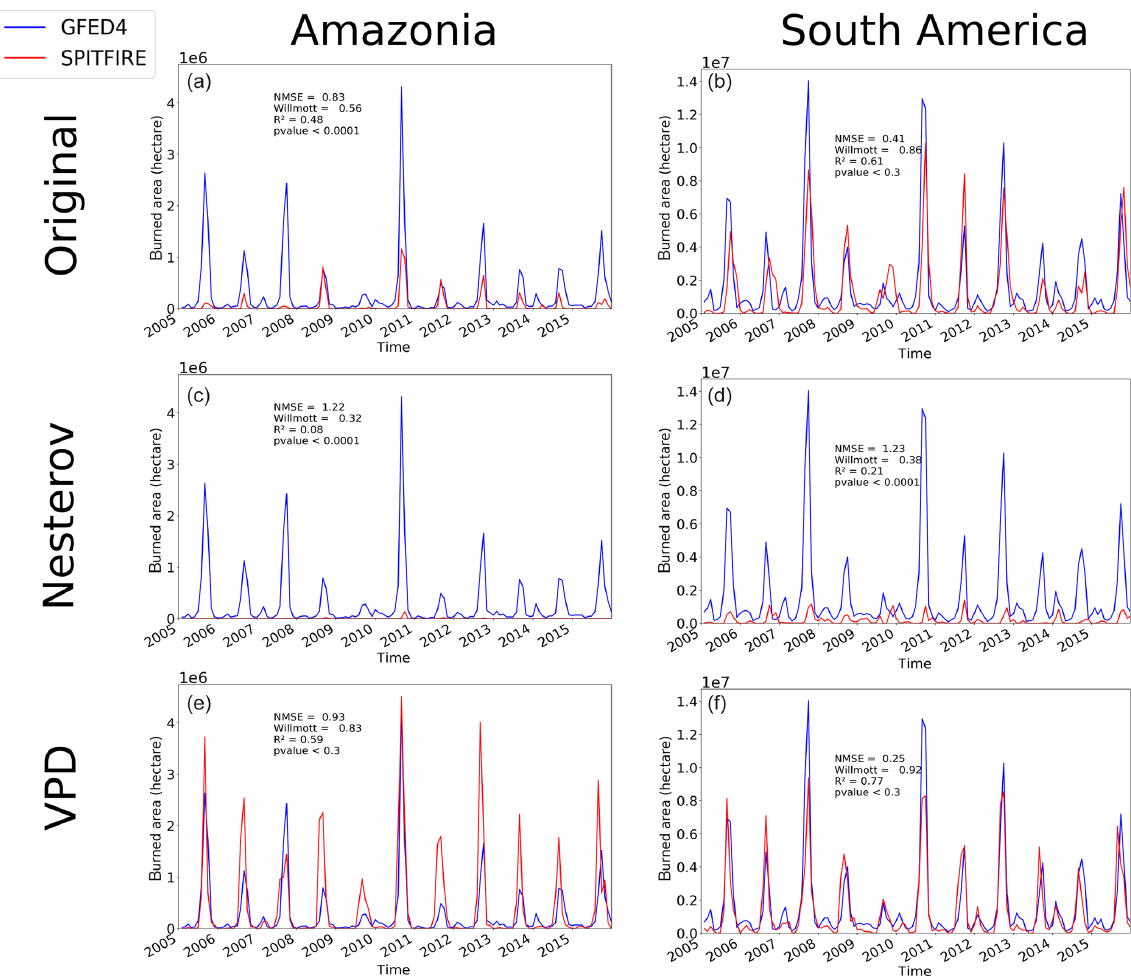
Figure A3. Time series of monthly burned area from 2005 to 2015 simulated by SPITFIRE (red lines) compared to GFED4 evaluation data (blue lines) for (a) the Amazonia region using NI orig , (b) total South America using the NI orig , (c) the Amazonia region using NI optim , (d) total South America using NI optim , (e) the Amazonia region using VPD optim , and (f) total South America using VPD optim .